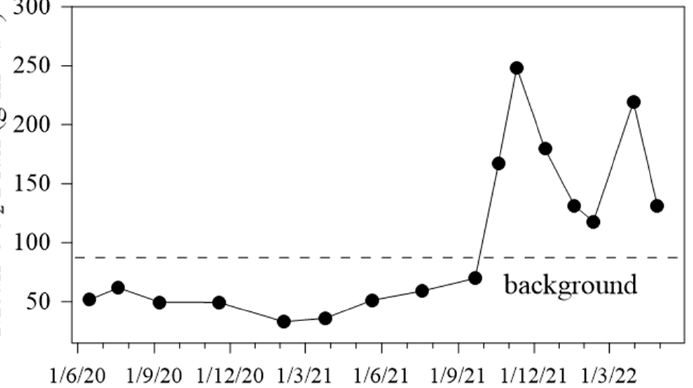
Figure 9. Temporal variation of soil CO 2 flux from June 2020 to April 2022. Each point is the average value of 53 flux measurements performed in the area of Vulcano Porto and at the base of the La Fossa cone.